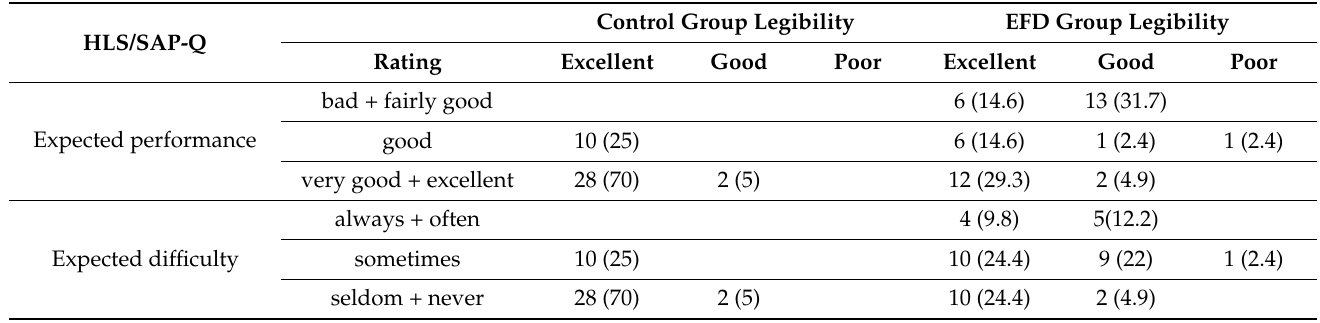
Table 3. Crosstab test for distribution between the expected performance and expected difficulty, and the HLS total